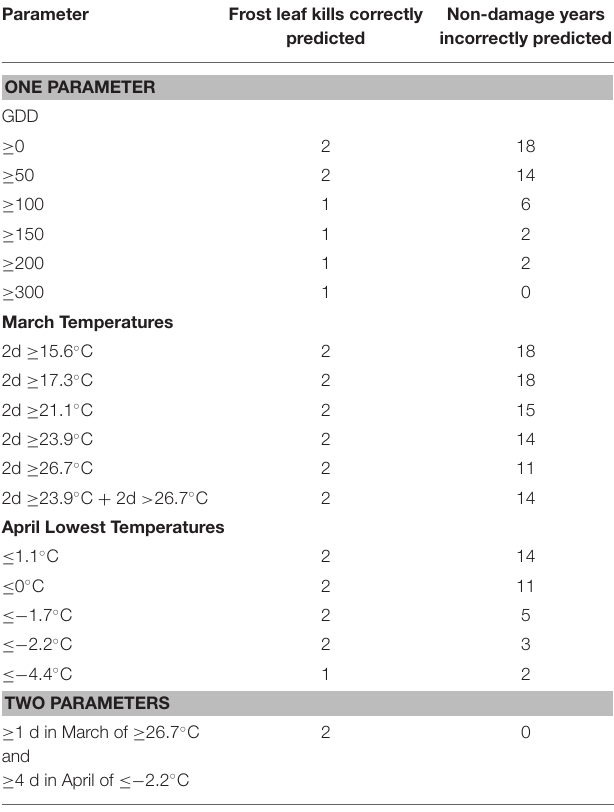
TABLE 1 | Error matrix for parameter(s) used to predict number of years between 1991 and 2010 with observed frost damage to leaves.